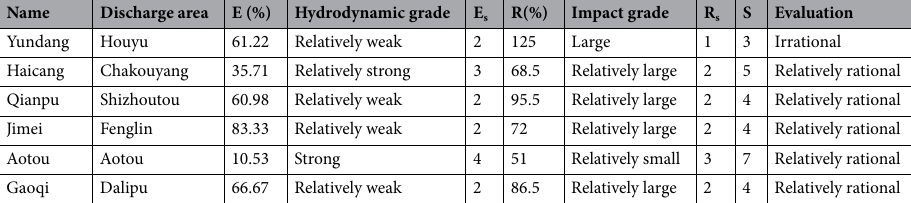
Table 8. Comprehensive evaluation of sewage outfalls in XMB in 2025.